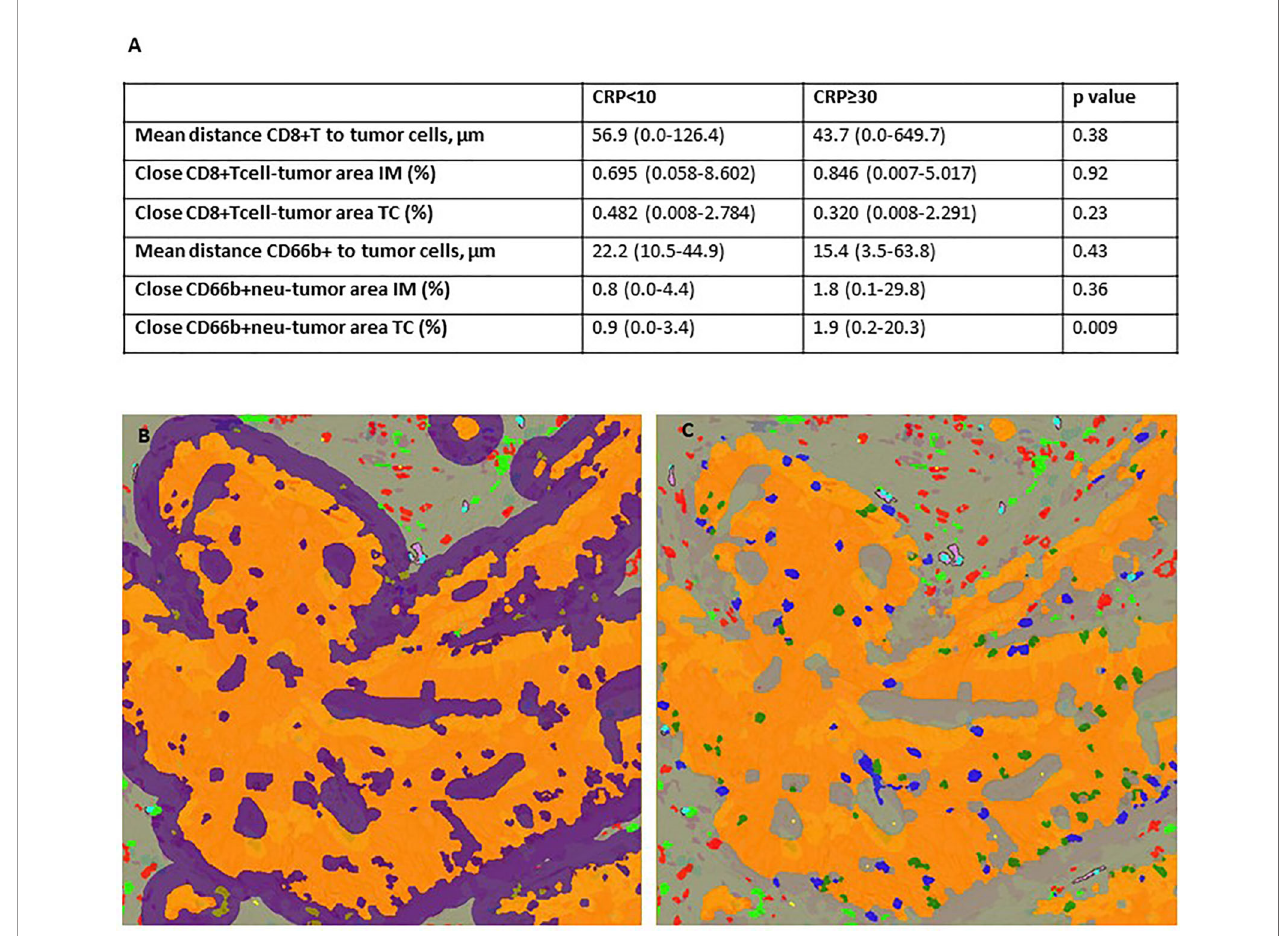
FIGURE 7 | Spatial distribution of CD8+T-cells and neutrophils in CRP-high and -low colon cancer patients. (A) Table showing median (range) of various spatial relationships. p-values were obtained using the Kruskal – Wallis test. (B) Close immune cells to the tumor area of either CD8+ T cells or CD66b+ neutrophils estimated by outlining 20 m m around tumor islet. (C) Nearest neighbor analysis estimating the average distance between immune cells of interest (either CD8+ T cells or CD66b+ neutrophils) and nearest tumor